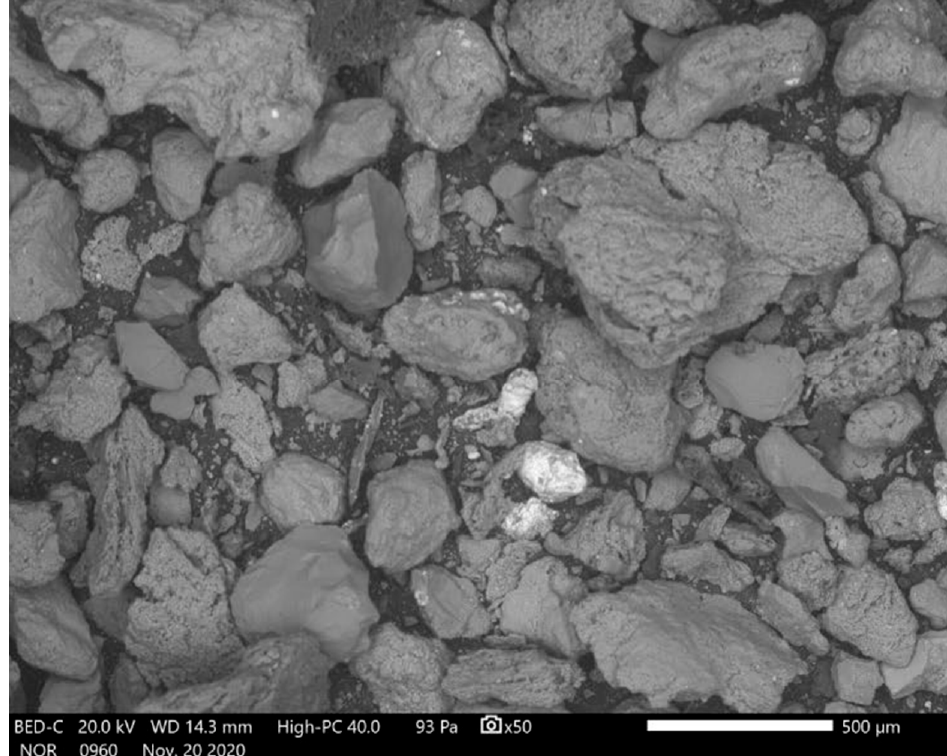
Figure 8. SEM image of bottom ash [102].